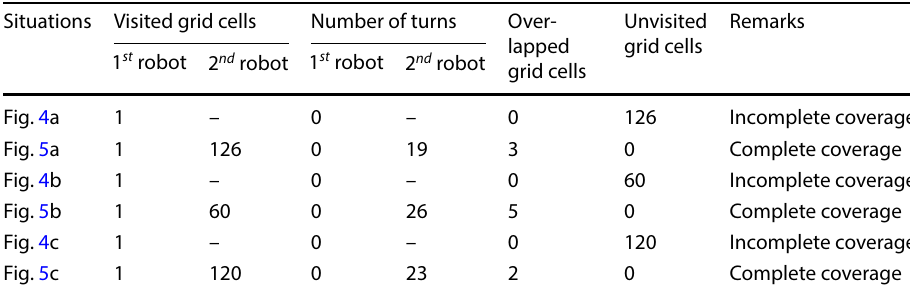
Situations Visited grid cells